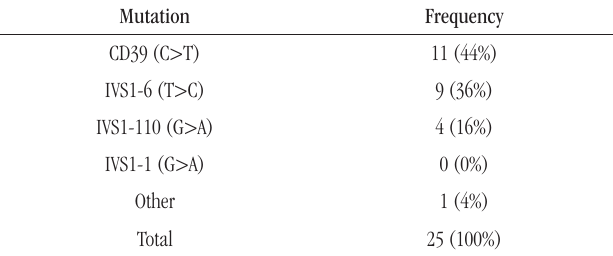
taBLE 2 − Frequencies of the mutations found in the study Mutation